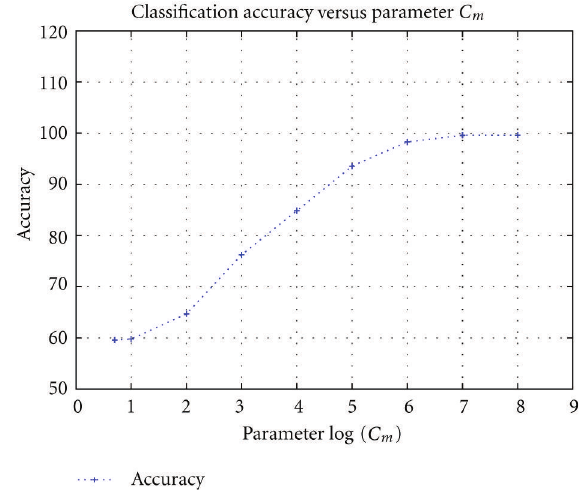
Figure 10: Relation between parameter C m and accuracy on Integrity Impact.